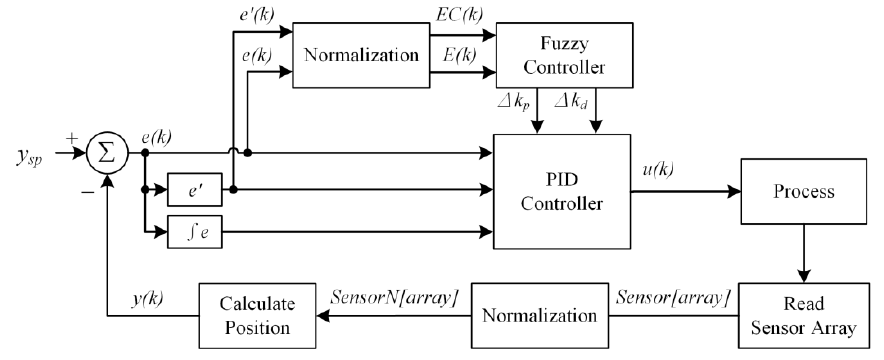
Figure 3. Fuzzy-PID control system architecture diagram.